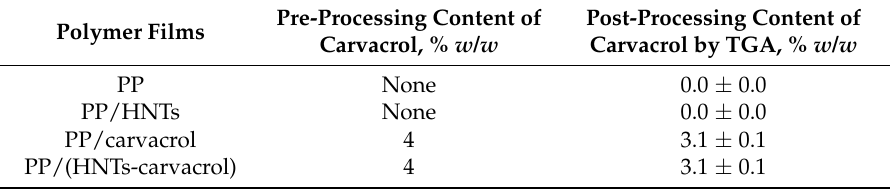
Table 2. Carvacrol content in different films measured by thermal gravimetric analysis